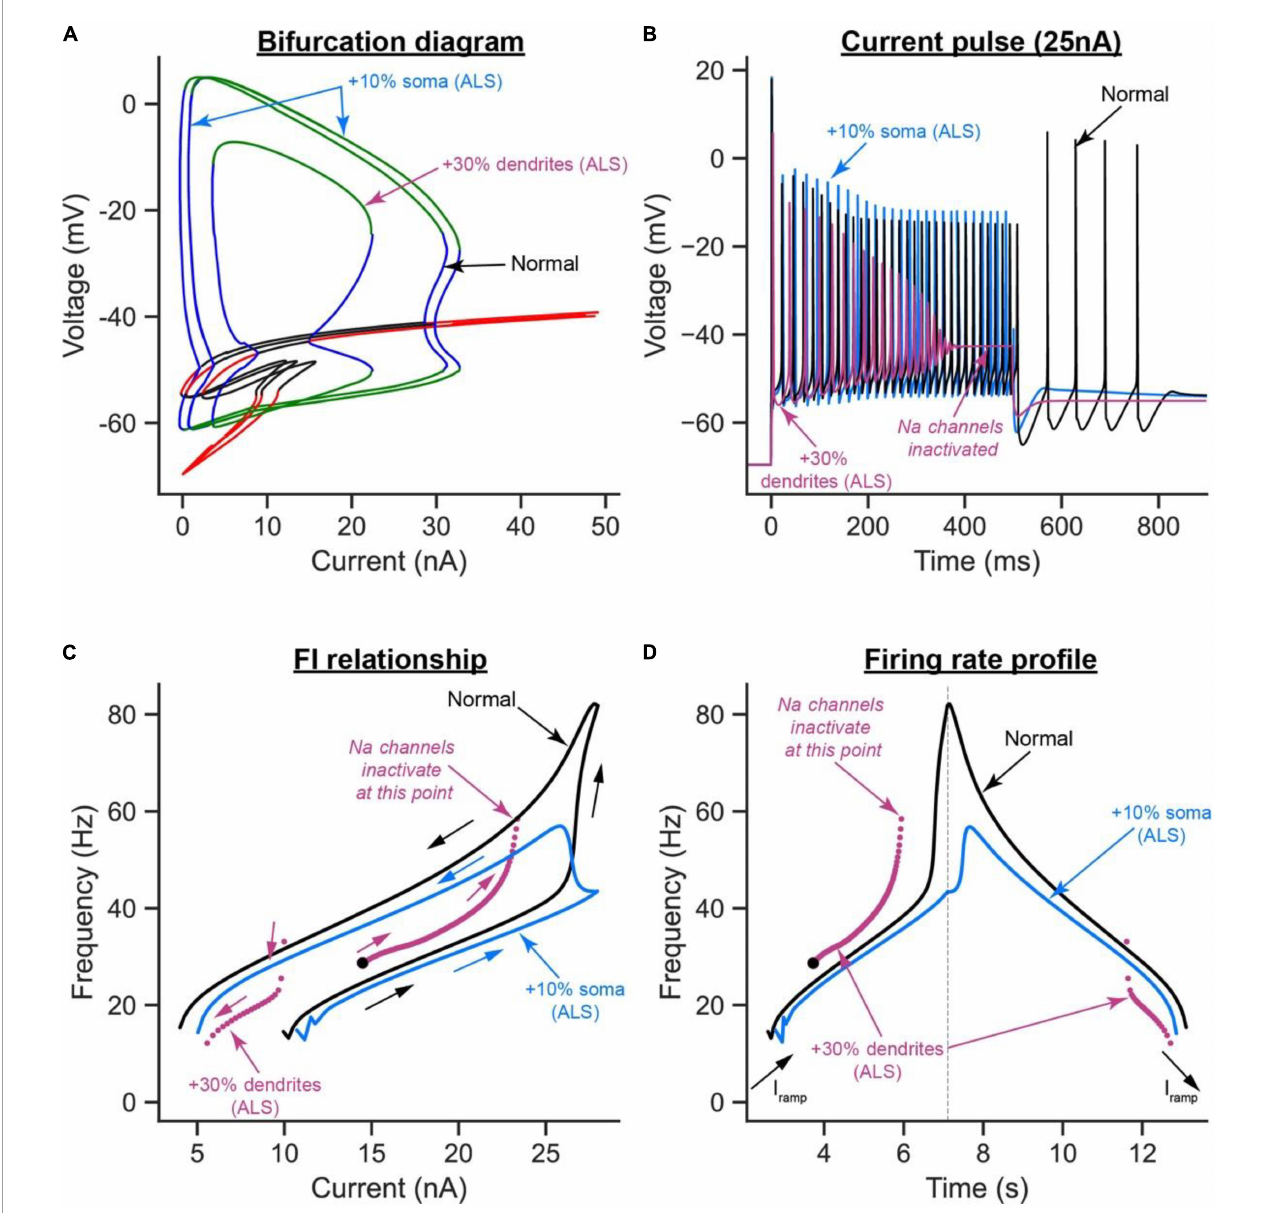
FIGURE7 The effects of somatic vs. dendritic size enlargement in ALS on MN firing. (A) The V-I bifurcation diagrams, (B) cell firing on a 25 nA long current pulse, (C) FI relationships during ramp current injection, and (D) firing rate profiles of the control model (normal condition, black traces) compared to the ALS model with the somatic area increased by 10% (blue traces) or the ALS model with the dendritic area increased by 30% (purple